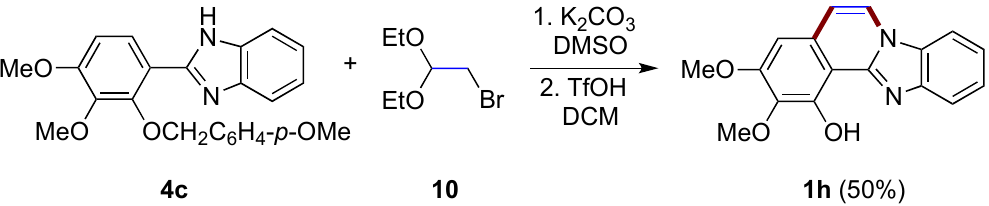
Figure 9. Synthesis of diversely functionalized benzimidazo[2,1- a ]isoquinoline 1h with the use of bromoacetaldehyde derivative 10 .